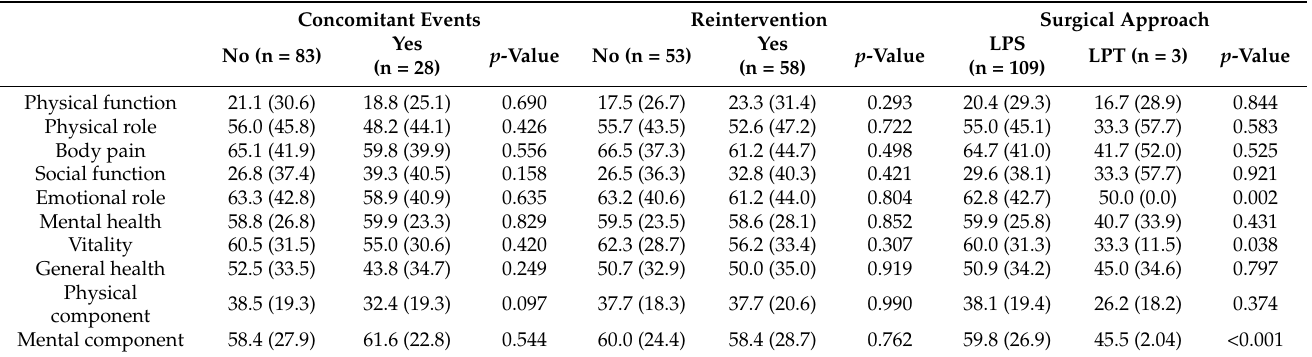
Table 5. Dimensions and components of SF-12 among women with concomitant events, reinterven- tion, and surgical